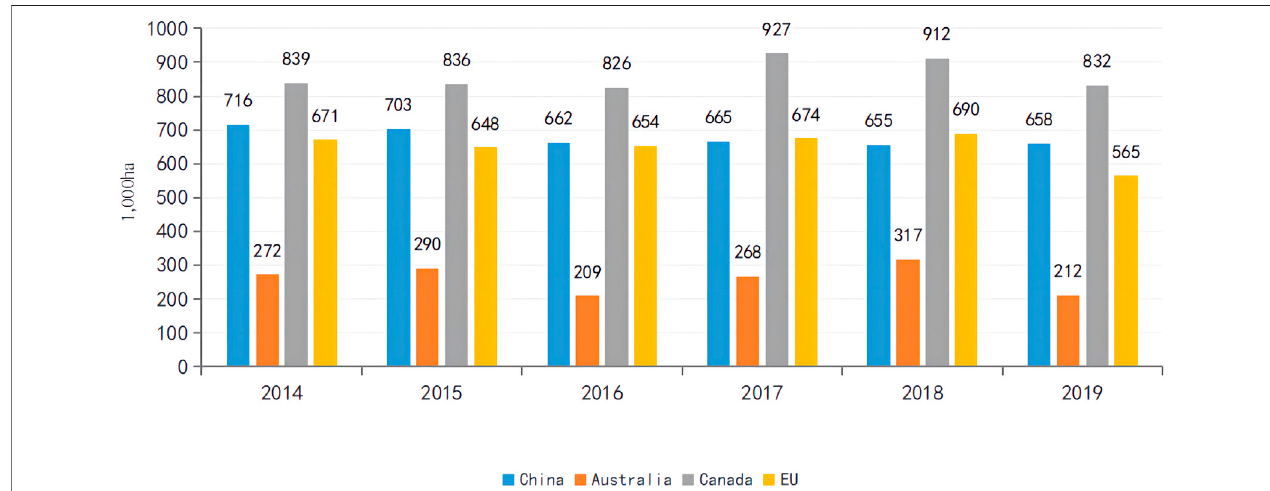
FIGURE 1 | Planting area of rapeseed in major producing countries from 2014 to 2019.